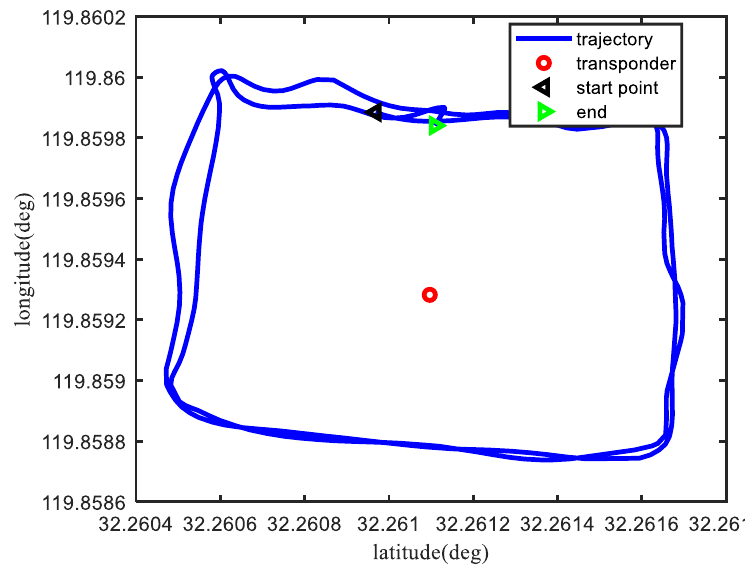
Figure 7. The vehicle trajectory in the field test. The position error of different algorithms is shown in Figure 8.